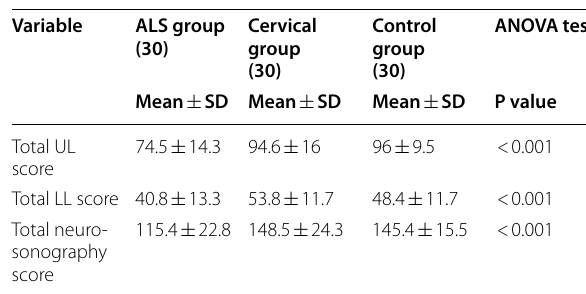
Table 6 Comparison between the three groups as regards (total) neuro‑sonography data using ANOVA test